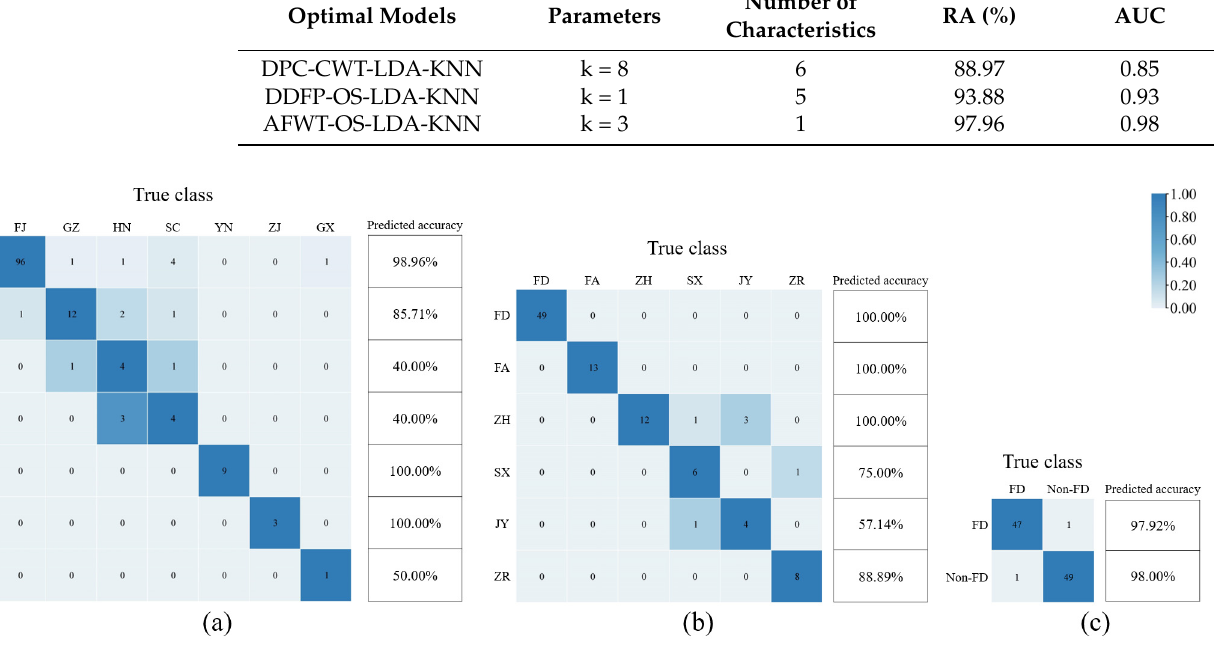
Figure 6. Confusion matrix for the best models. ( a ) DPC-CWT-LDA-KNN; ( b ) DDFP-OS-LDA- KNN; ( c ) AFWT-OS-LDA-KNN. ( c )